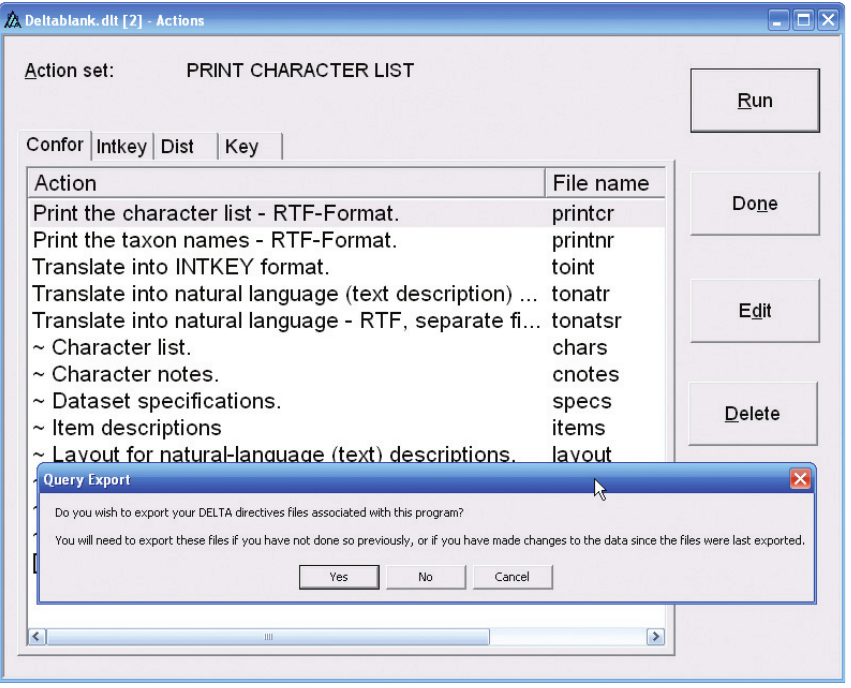
Figure 24. When running a directive fi le the program asks for an export of the directive fi les.